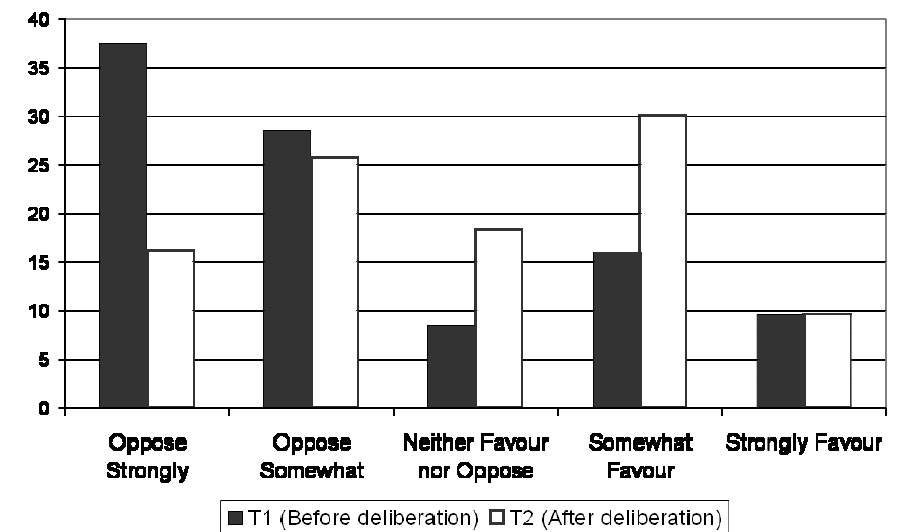
Fig. 1: Opinions on raising the retirement age, before (T1) and after deliberation (percentage values)